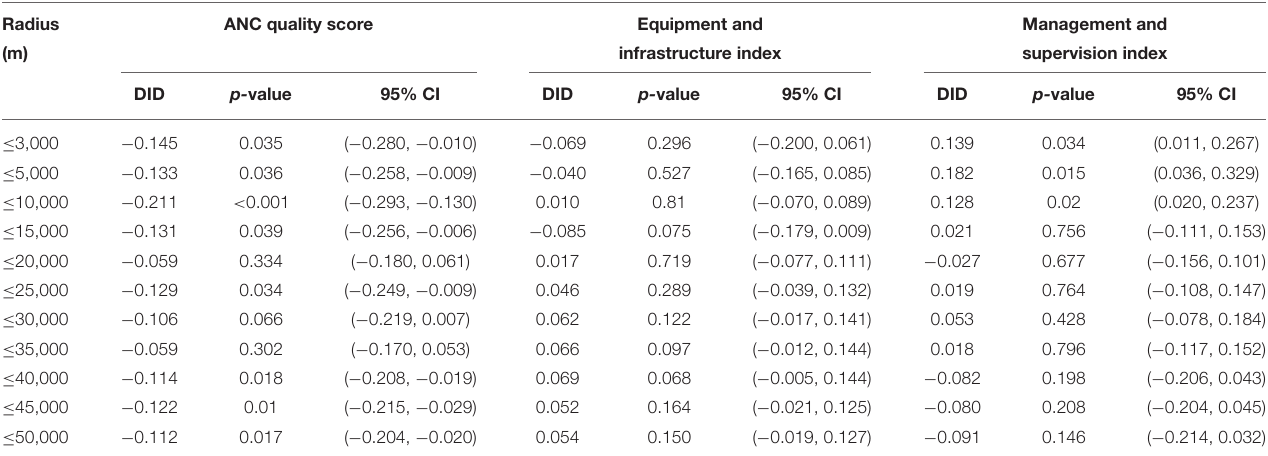
TABLE 11 | Variation in DID estimates with catchment area radius.